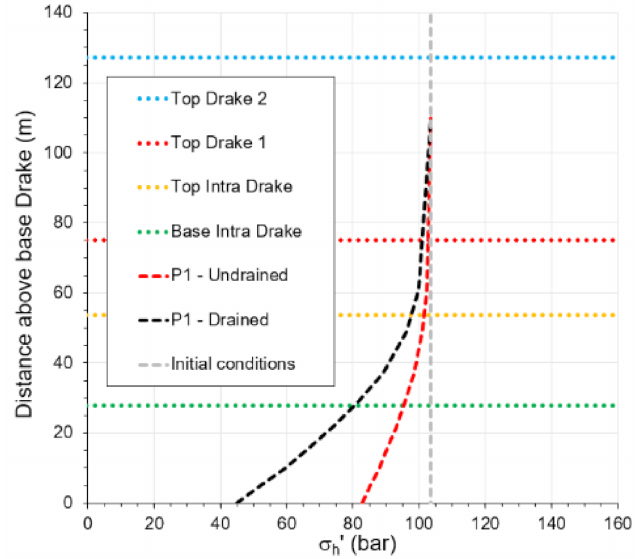
Figure 6. Potential effective stress profile (P1—1 percentile case) distance above base Drake/top Cook after 25 years of cooling for two extreme cases (fully drained and undrained).